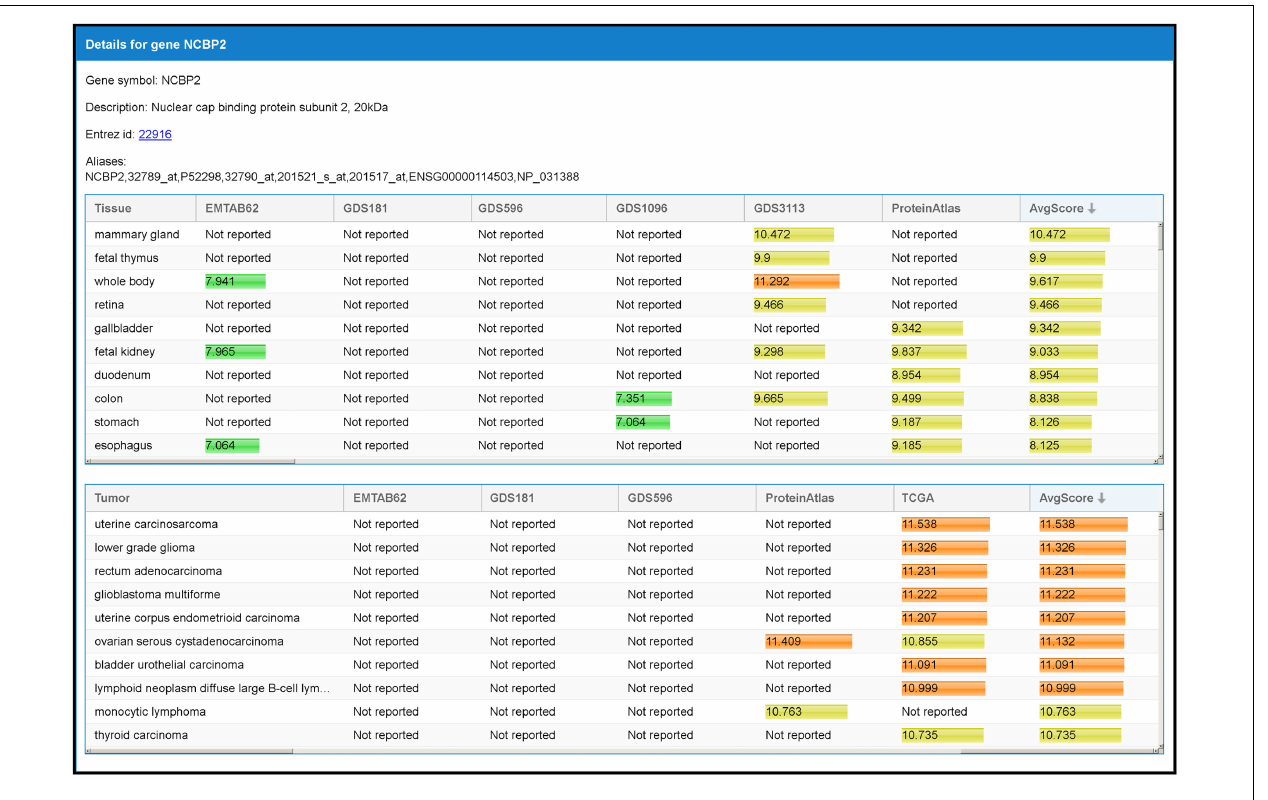
description, the corresponding ID in Entrez Gene database (when available), and aliases (including references in other databases) are reported. Finally, two tables with the set of tissues and tumors where the gene is expressed are shown. These are shown in decreasing order with respect to the average expression